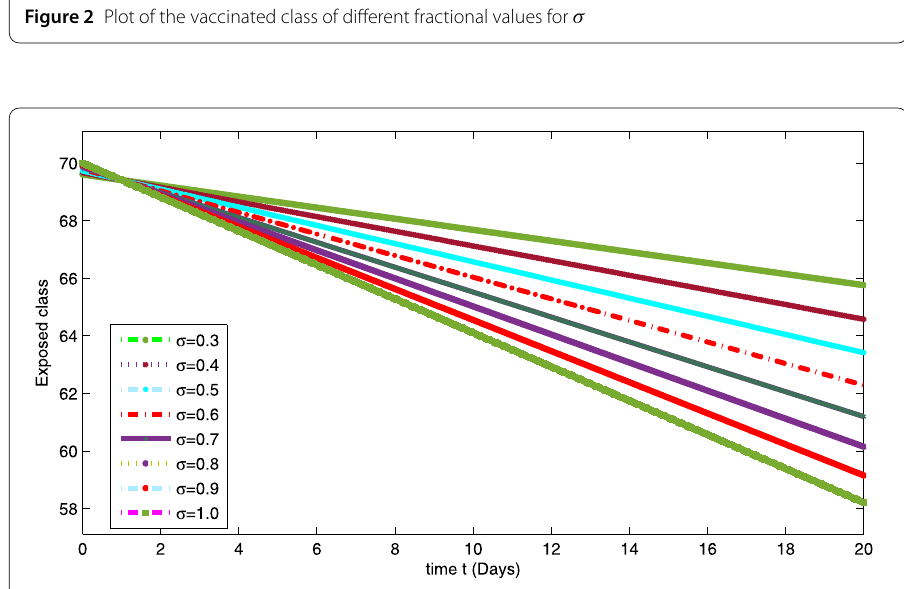
Figure 3 Plot of the exposed class of different fractional values for σ